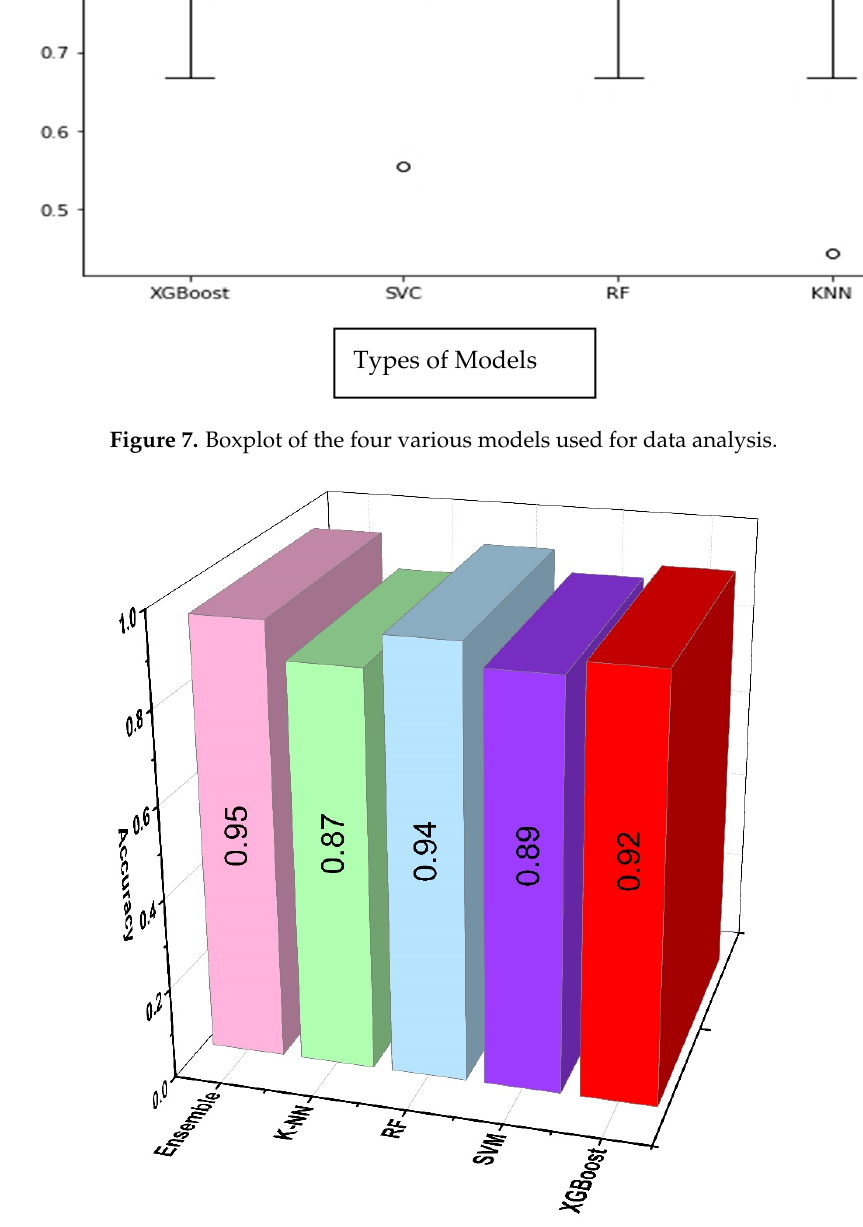
Figure 8. The calculated accuracy obtained through data mining models.